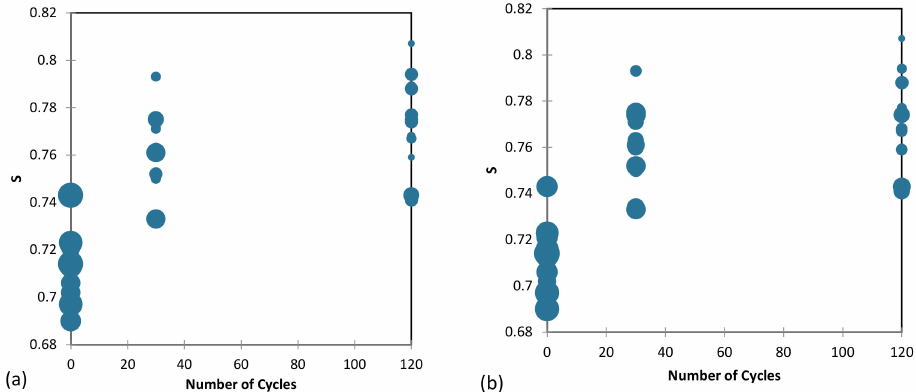
Figure 19. Effects of cycling loading on ( a ) e min and ( b ) e max based on the sphericity S parameter.